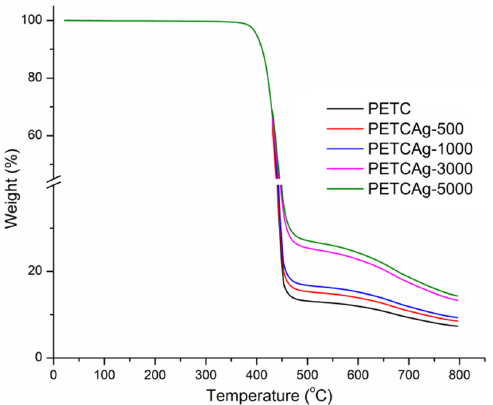
Figure 6. Silver quantification on PETCAg films by TGA under nitrogen flow.